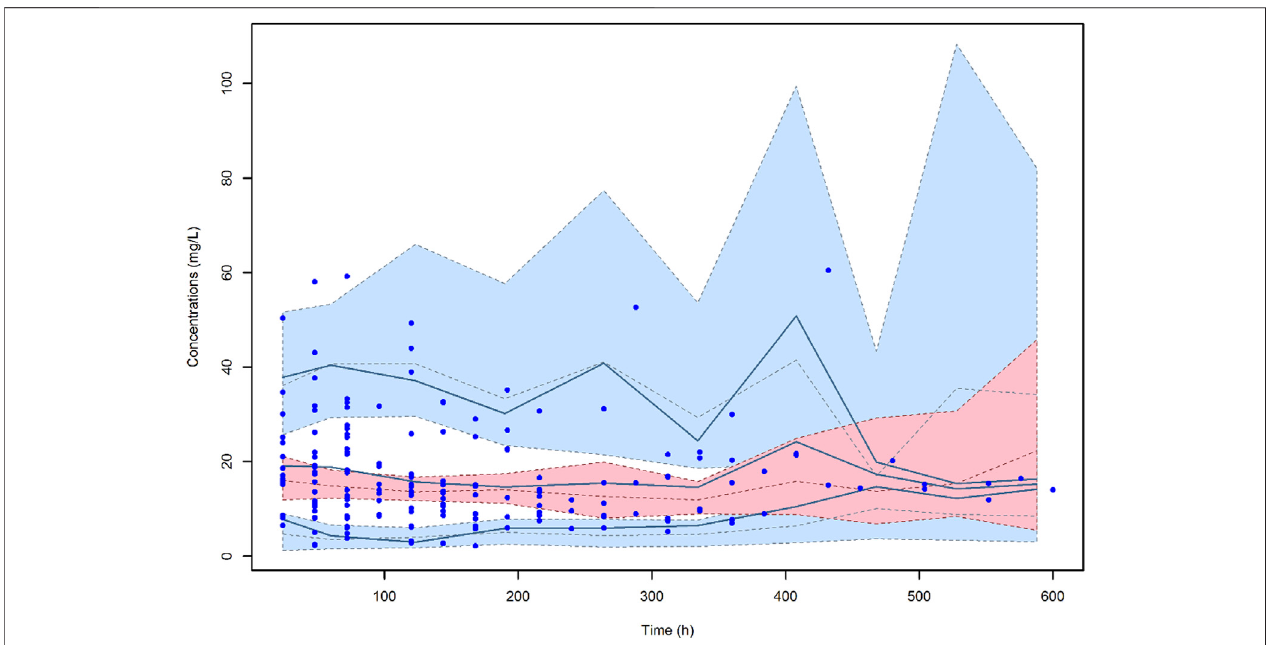
FIGURE 4 | Visual predictive check (VPC) of meropenem plasma concentration-versus-time for the fi nal model. The continuous lines indicate the 10th, 50th and 90th percentiles for observed data, while the shaded areas represent 90% prediction intervals from the corresponding percentiles calculated from simulated data.